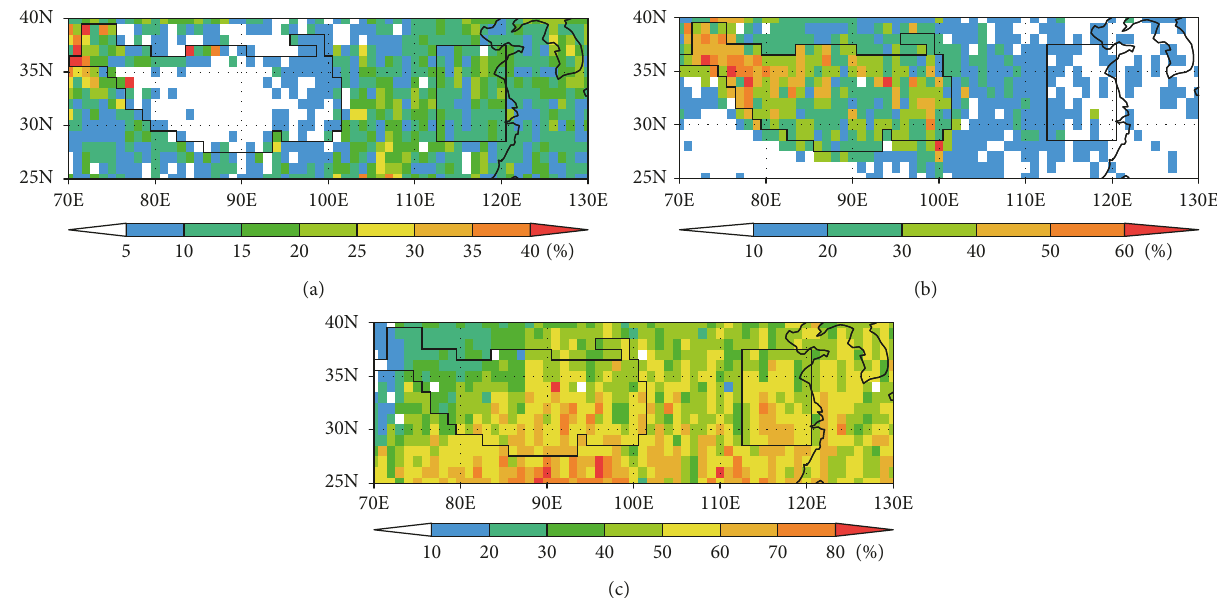
Figure 6: Occurrence distributions of (a) warm clouds, (b) mixed-phase clouds, and (c) ice